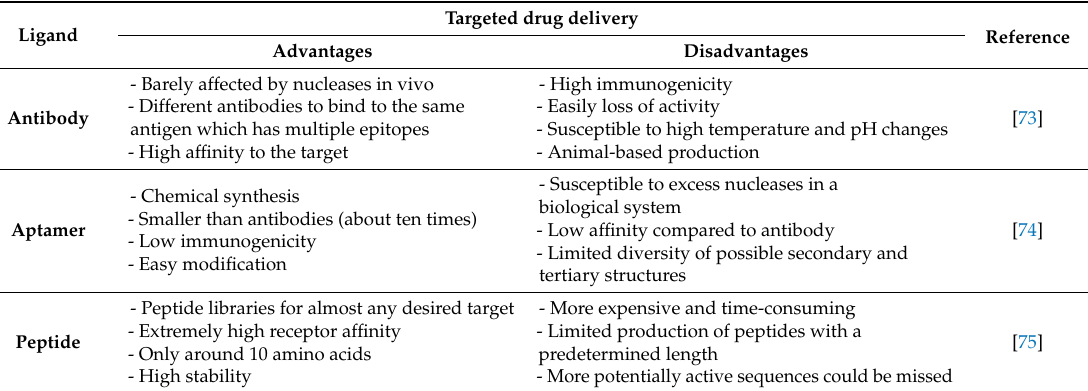
Table 2. Advantages and disadvantages of different targeting ligands.